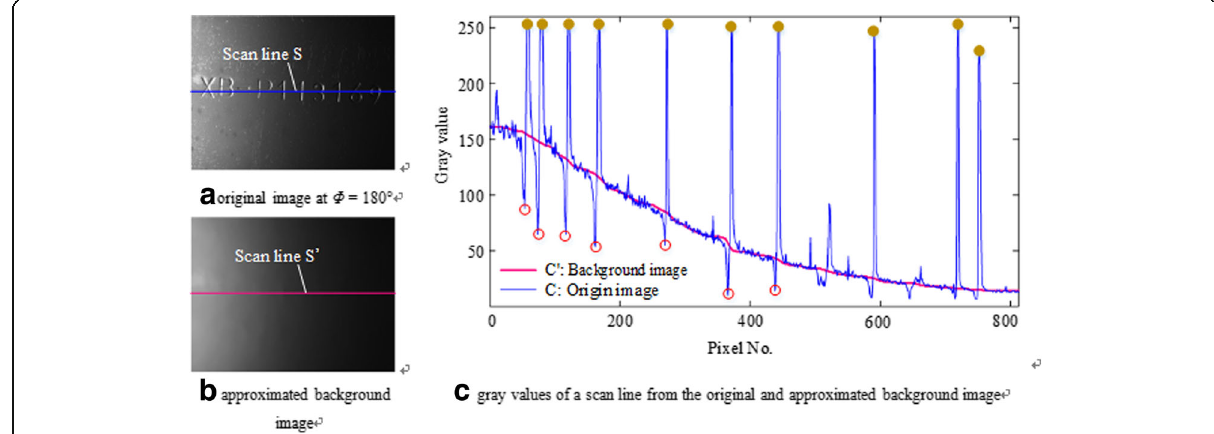
Fig. 2 a – c Result of image background extraction and comparison of scan lines from the original and background